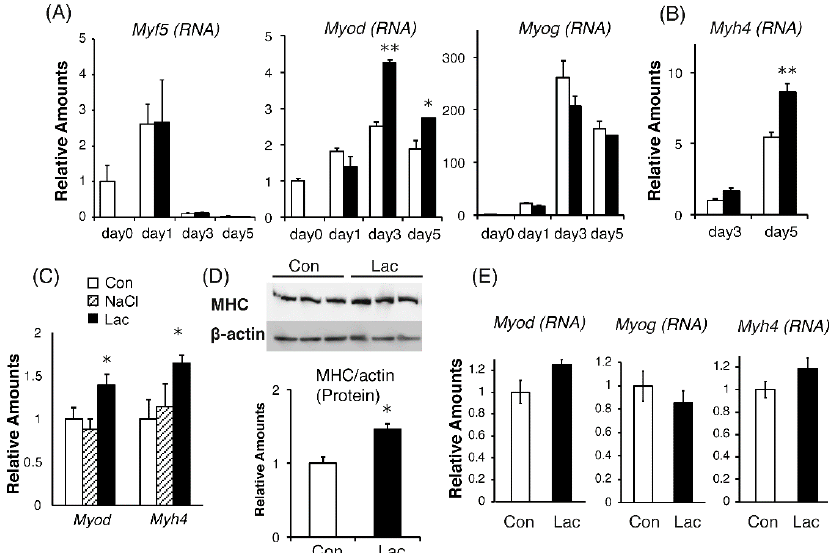
Figure 2. Lactate enhanced expression of myogenic determination protein (Myod) and Myh4 genes and MHC protein in C2C12 myotubes. C2C12 cells ( A to D ) and primary myoblasts ( E ) were differentiated in control medium (open bar), or medium containing 10 mM sodium lactate (closed bar) or 10 mM sodium chloride (hatched bar). Cells were harvested on the indicated day of differentiation and messenger RNA (mRNA) expression levels of representative myogenic markers were determined by real-time PCR. ( A ) Myf5 , Myod , and Myog ; ( B ) Myh4 ; and ( C ) Myod and Myh4 . RNA levels were quantified and normalized to that for GAPDH. Values are each expressed as the fold change compared with day 0 in ( A ), with control on day 3 in ( B ), and with control on day 5 in ( C ), with each the value used for normalization arbitrarily set to 1. ( D ) Cells were harvested on day 5. MHC protein levels were determined and normalized to those of β -actin. ( E ) Primary myoblasts were differentiated for 3 d and mRNA expression levels of Myod , Myog , and Myh4 were determined. n = 3–4 per group. Results are expressed as means ± SE. * p < 0.05; ** p < 0.01; versus each control group.